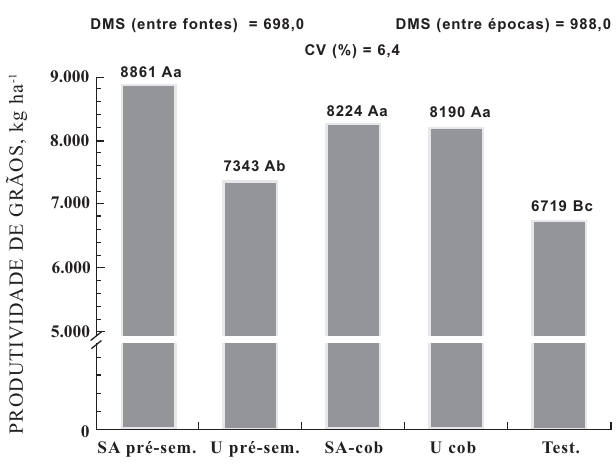
Test.U cobSA-cobU